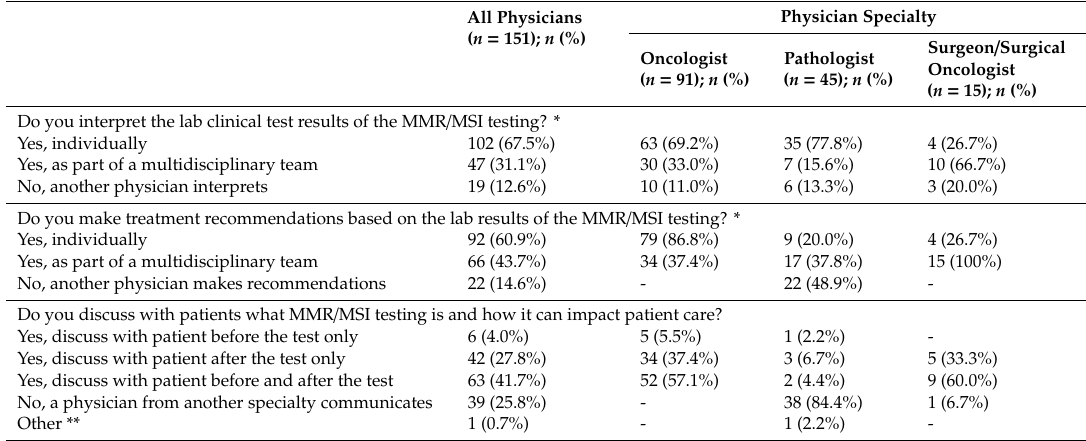
Table 3. Interpretation and discussion of MMR / MSI test results.